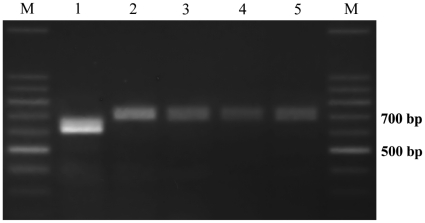
Polymorphic PCR fragments amplified by specific primers RP5.11 in five strains of R. dominica: SRQLD (1), SQLD(2), WRQLD(3), SRNSW(4), SRSA(5), M(100 bp DNA ladder).The short fragment polymorphism is unique to SRQLD.